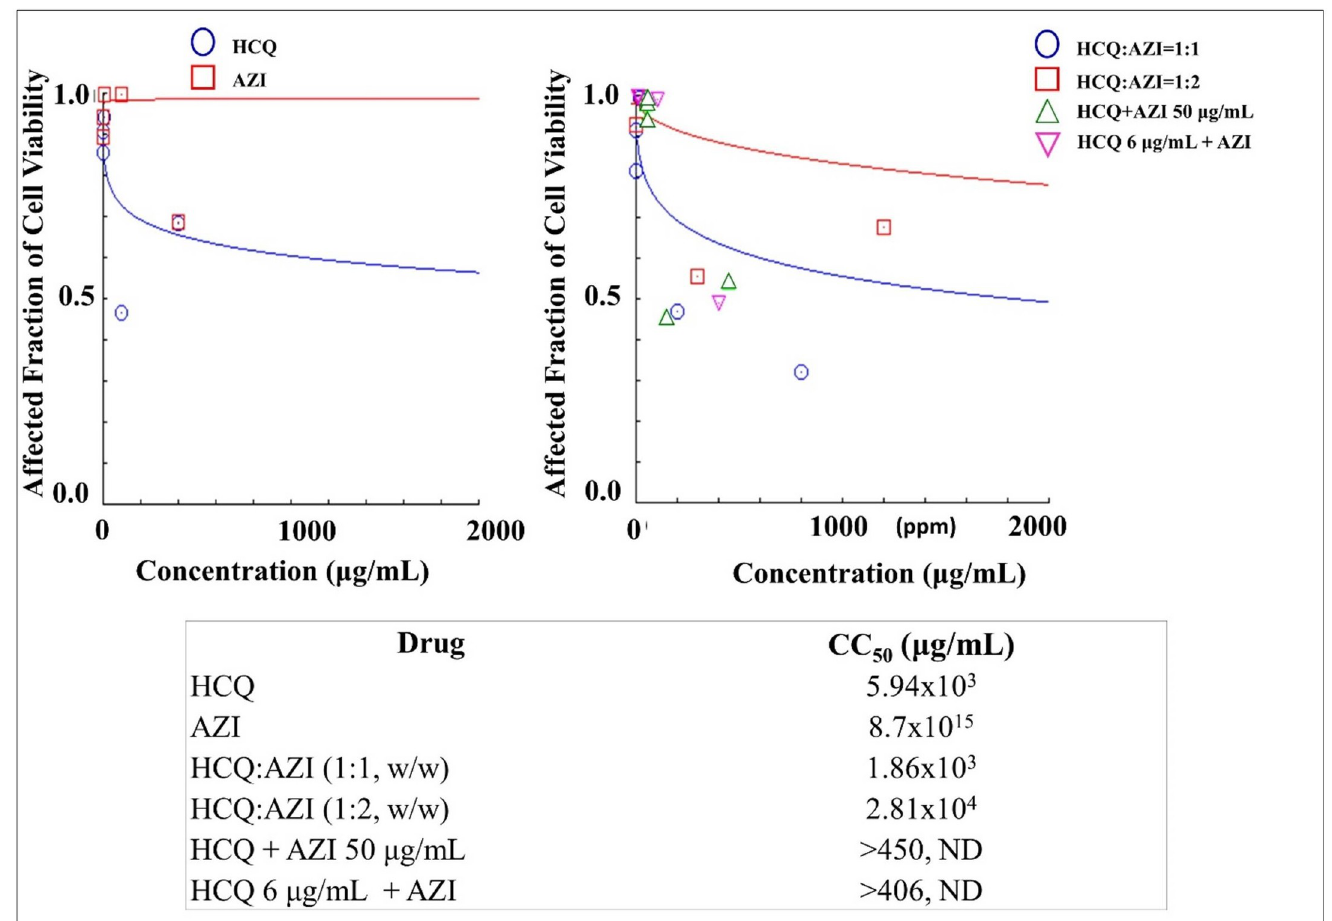
Fig 7. The cytotoxicities of Hydroxychloroquine (HCQ) and Azithromycin (AZI) as a single drug (left) and dual drug combination in constant and non- constant ratios (right) analysed by using CompuSyn Software (n = 3). At non-constant ratios of HCQ + AZI 50 μ g/mL, AZI was added at a concentration of 50 μ g/ mL to each increased levels of HCQ i.e. 0.2, 2, 10, 100, and 400 μ g/mL. On the other hand, HCQ was then added at a concentration of 6 μ g/mL to each increased levels of AZI i.e. 0.2, 2, 10, 100, and 400 μ g/mL to produce HCQ 6 μ g/mL + AZI.